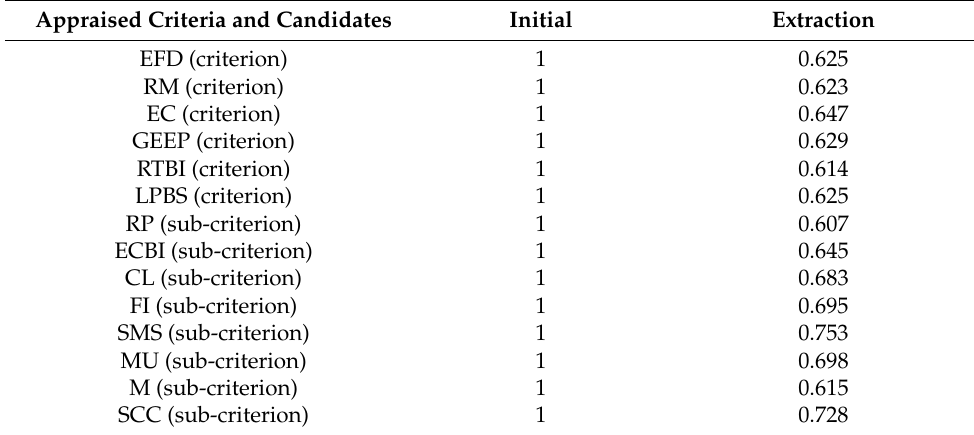
Table 3. The commonality of each assessed criterion in FA the of quantitative